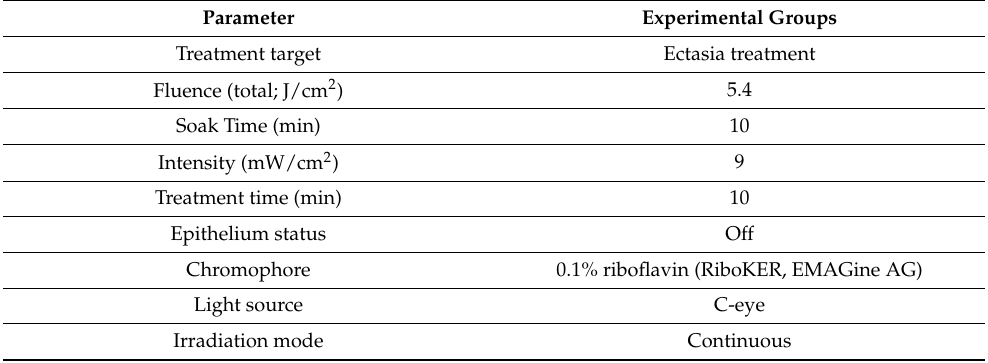
Table 1. Corneal cross-linking procedure: cross-linking device technical settings, irradiation protocols, and riboflavin